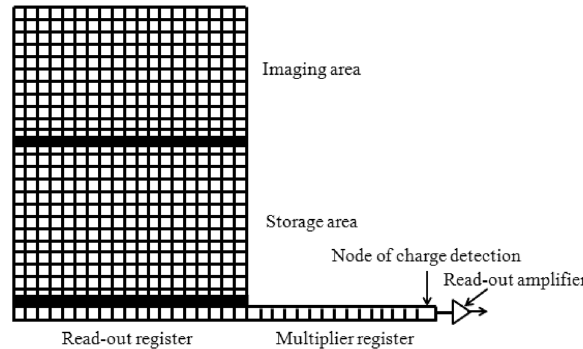
Figure 1. Schematic diagram of EMCCD